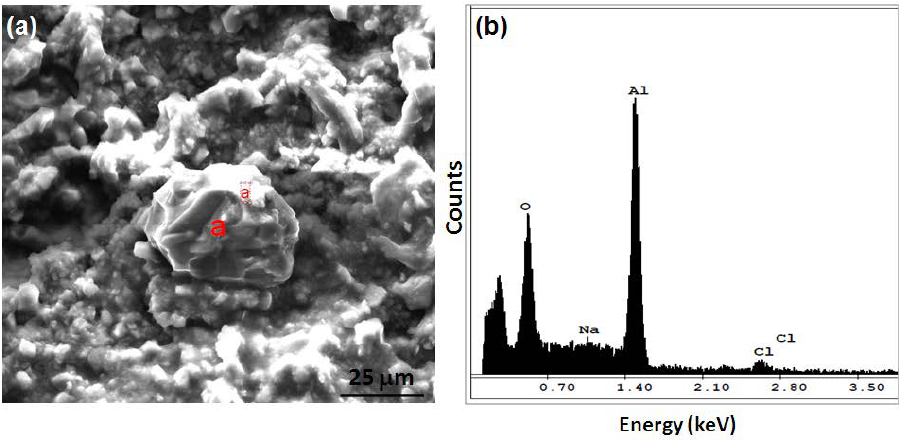
Figure 8: SE SEM image: (a) particle a in damaged portion of the antenna (location A) and (b) corresponding EDS pattern of particle